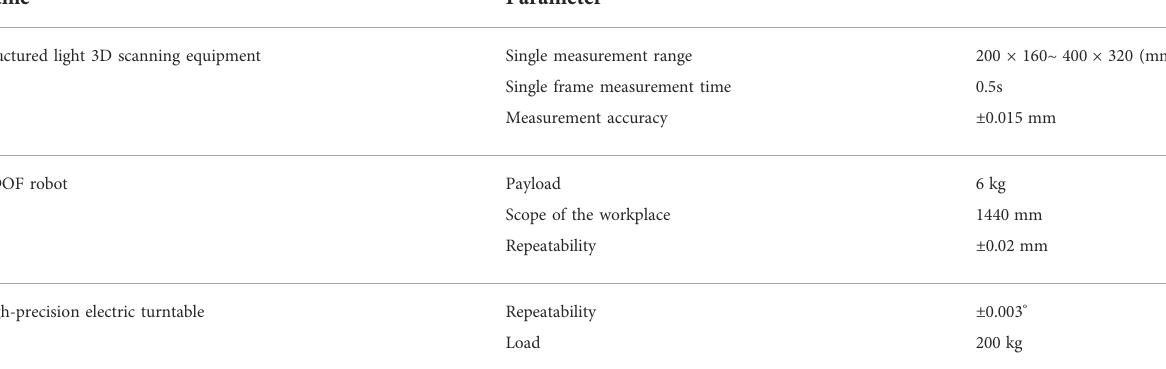
TABLE 1 Hardware device